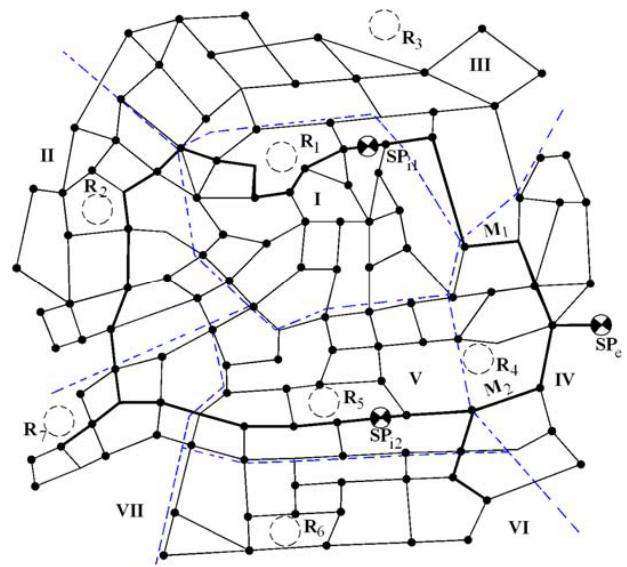
Figure 7. Schematic of the analysed distribution network.